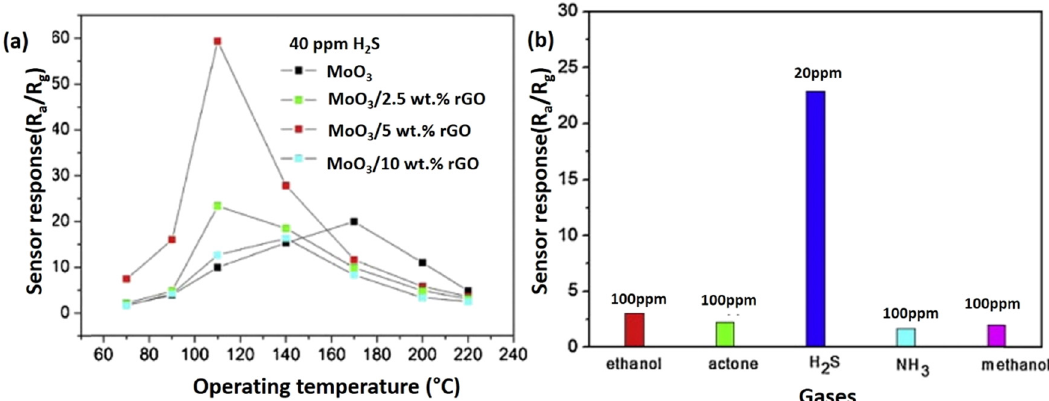
Figure 28: ( a ) Sensor response to 40 ppm of H 2 S and ( b ) response of 5 wt% of rGO/ α - MoO 3 nanocomposites - based sensor towards di ff erent gases analysis 100°C operating temperature. Reproduced from ref. [ 174 ]